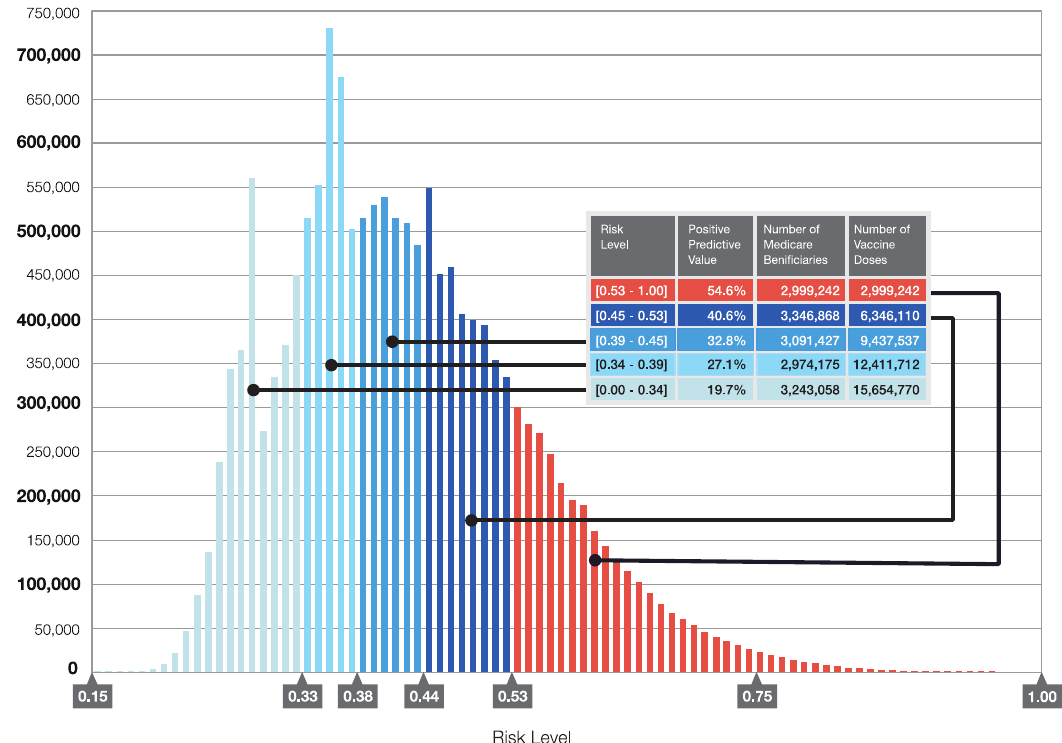
Figure 5. COVID-19 Vaccine Prioritization Based on Risk of Severe COVID-19 Disease. The logistic regression model coefficients for the independent variables shown in Figure 1 were used to calculate the predicted probabilities of hospitalization in the Salus cohort. The distribution of predicted probabilities was split into five groups shown in the table of approximately 3 million beneficiaries each to enable stratification of the cohort by risk of severe disease to prioritize individuals for COVID-19 vaccination.